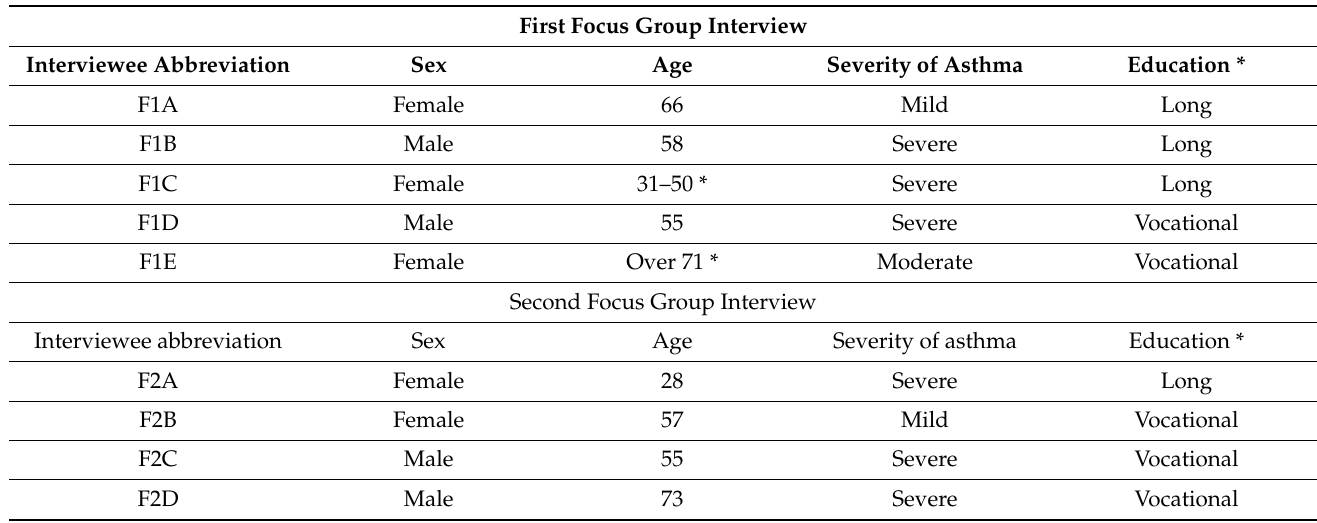
Table 2. Summary of patient characteristics of interviewees from both focus group interviews. * Information gathered from the online application form.